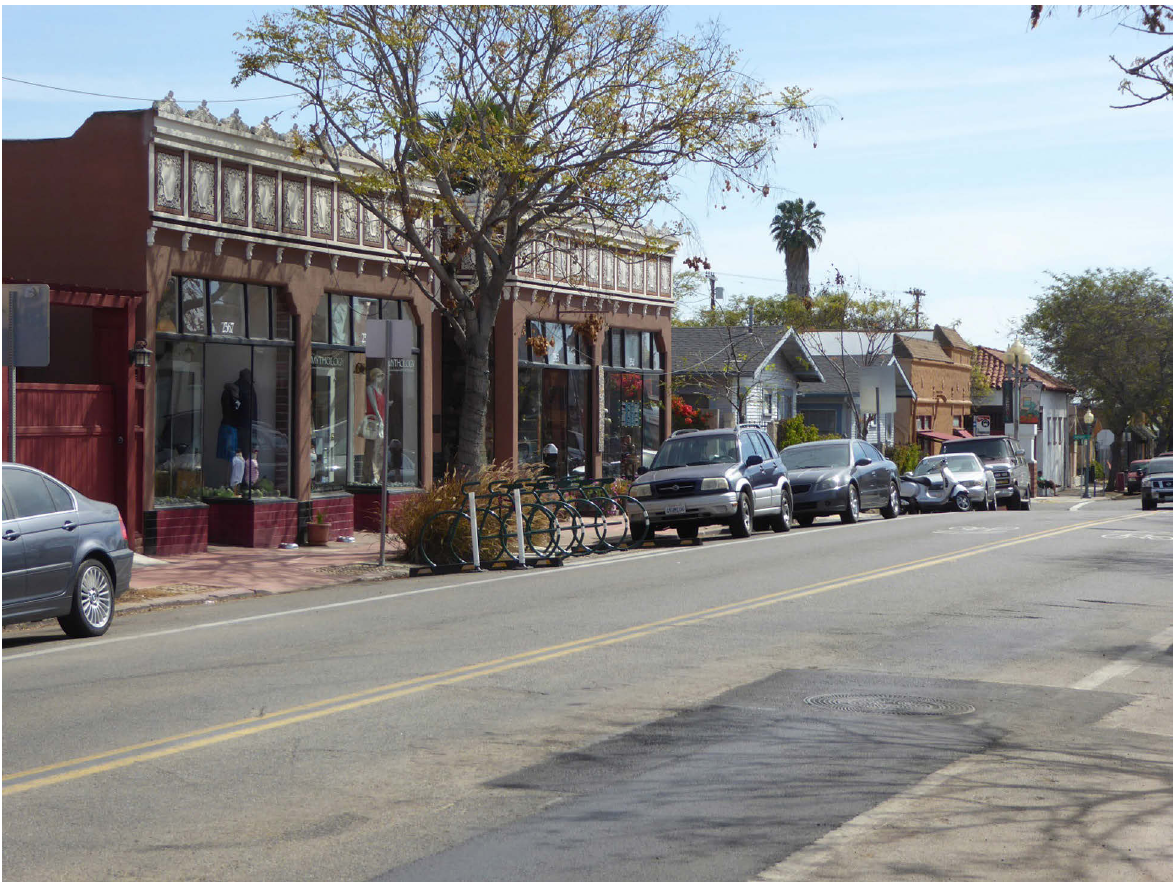
Fig. 2. Alternative fashion and applied-art shops keep appearing on the border of Burlingame and South Park (photo: Olaf Kühne